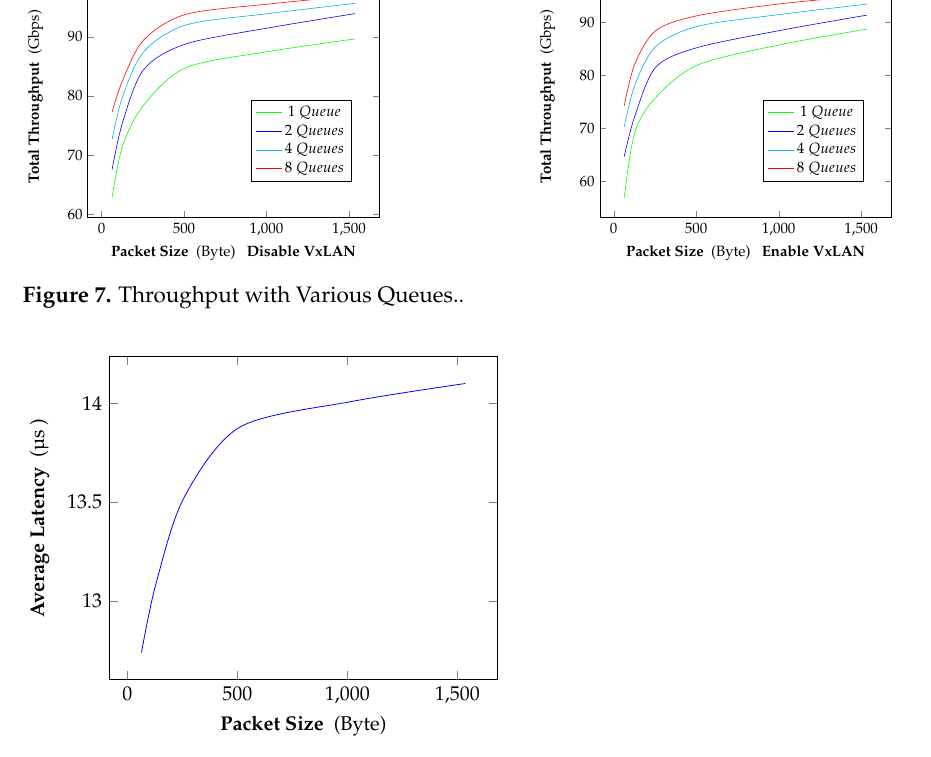
Figure 8. Forwarding Latency With Various Packet